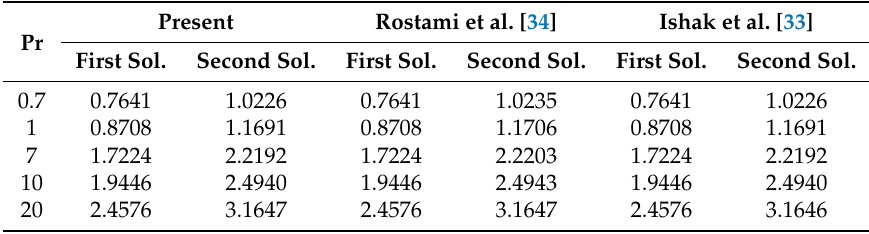
Table 6. − θ (cid:48) ( 0 ) when φ 1 = φ 2 = Z = d = 0 and λ = 1 for various values of